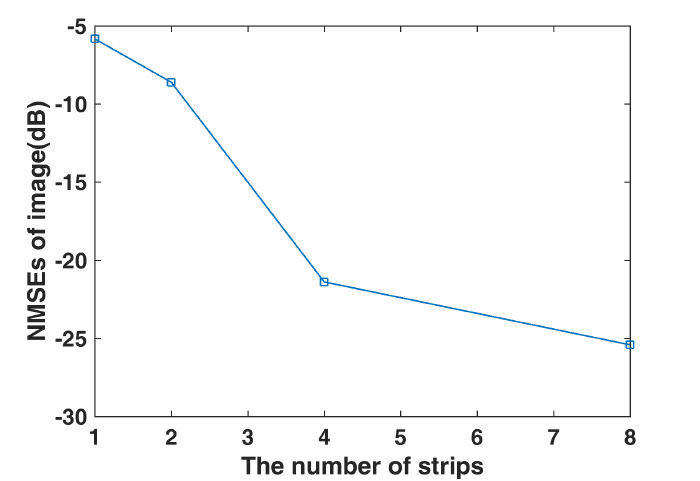
Figure 4. NMSE of target reconstructions under different number of